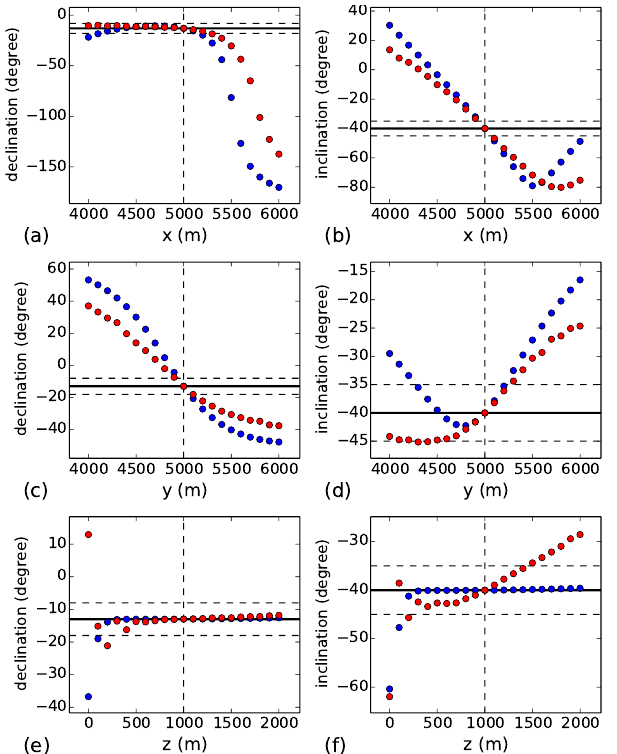
Figure 7. Robustness against errors in the centre location. The blue and red dots represent, respectively, the magnetization direc- tion of a simulated spherical body obtained with the least-squares ˆ h (Eq. 19) and robust e h (Eqs. 21 and 22) estimates. The estimated declinations and inclinations were obtained by presuming different positions for the centre of the source along the x , y and z axes. Along each axis, the magnetization direction was estimated by con- sidering 21 different centres regularly spaced in a range of 2000m on a line passing through the right coordinates of the centre of the simulated spherical body (vertical dashed lines). The continu- ous black lines represent the true declinations (or inclinations). The dashed lines represent the true declination (or inclination) ± 5 ◦ .